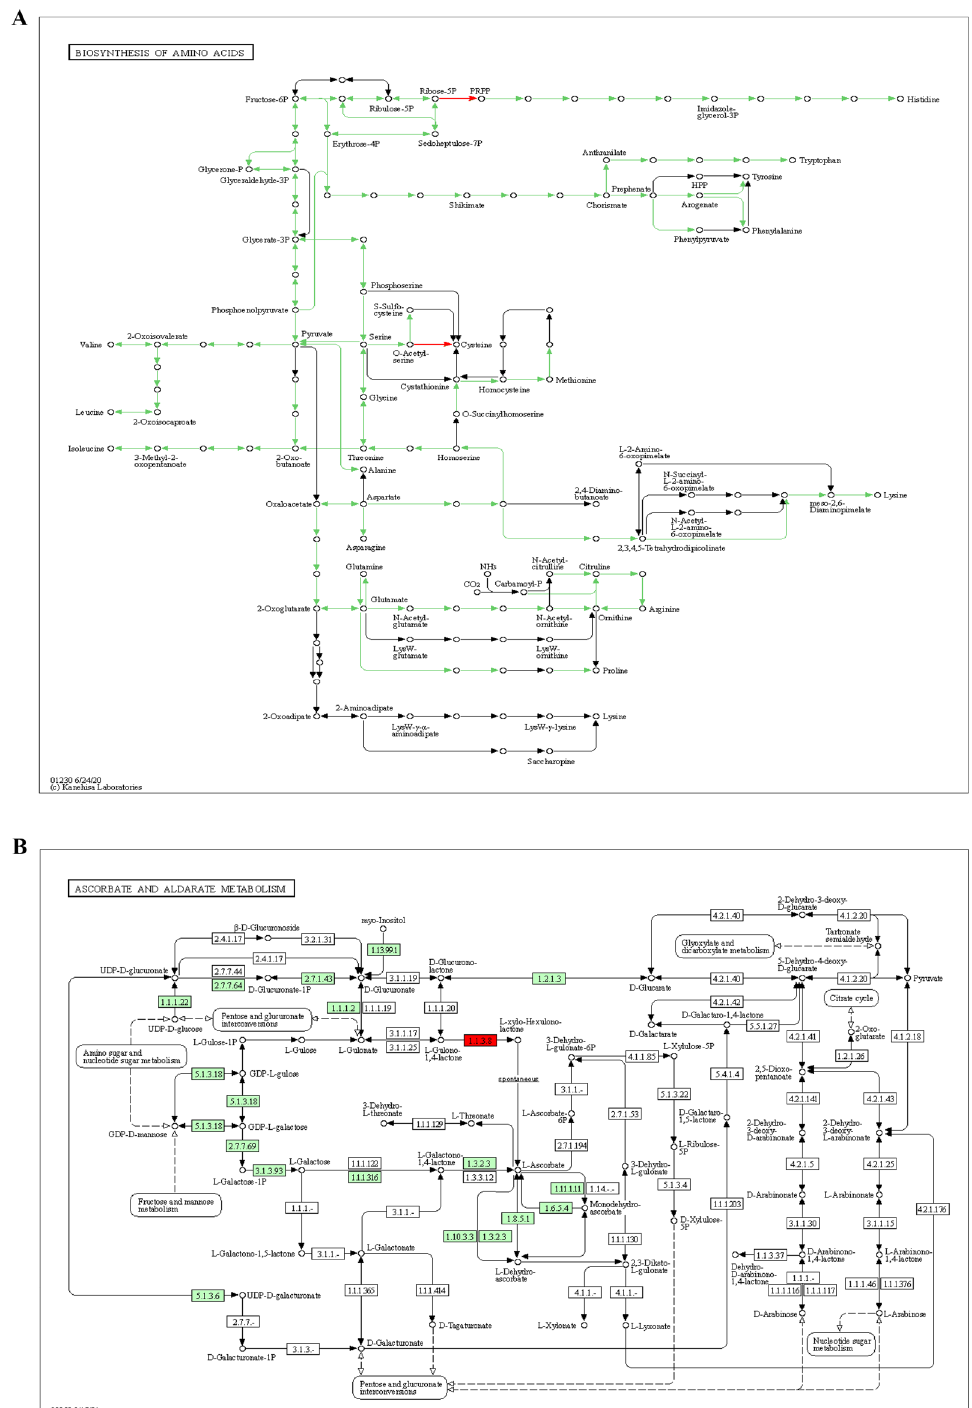
Figure 7. The KEGG pathway of biosynthesis of amino acids ( A ), the KEGG pathway of ascorbate and aldarate metabolism ( B